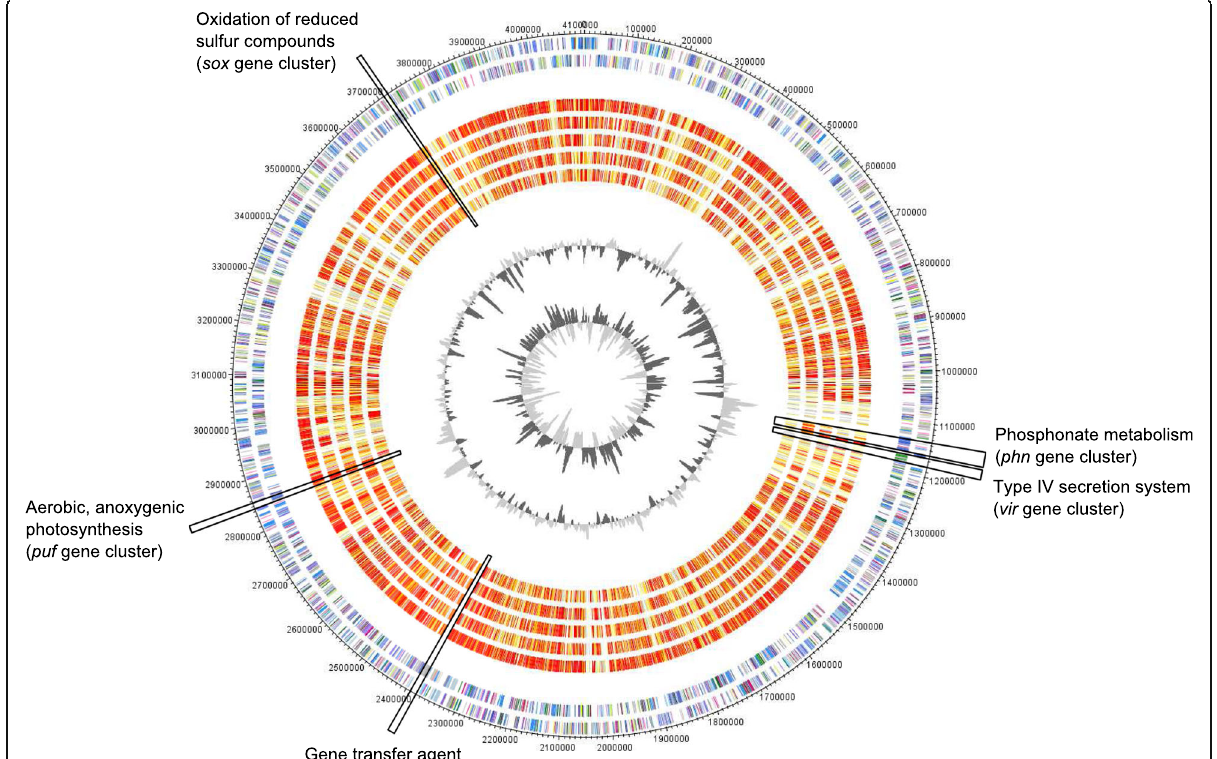
Fig. 3 Planktotalea frisia SH6-1 T artificial circular chromosome map. Genome comparison of P.frisia SH6-1 T with 6 genome sequenced members of the Pelagic Roseobacter Cluster [9]. Circles (from outside to inside): 1 and 2: Genes encoded by the leading and lagging strand of P.frisia SH6-1 T marked in COG colors in the artificial chromosome map; 3 – 7: The presence of orthologous genes is indicated for the genomes of Rhodobacterales bacterium HTCC2083, Planktomarina temperata RCA23 T , Rhodobacteraceae bacterium HIMB11, CHAB-I-5 SB2 and Rhodobacteraceae bacterium HTCC2255. The similarity of orthologous genes is illustrated in red to light yellow and singletons in grey (grey: >e − 10 -1; light yellow: <e − 50 - >e − 10 ; gold: <e − 50 - >e − 90 ; light orange: <e − 90 ->e − 100 ; orange: <e − 100 - >e − 120 ; red: <e − 120 -0). The two innermost circles represent the GC-content and the